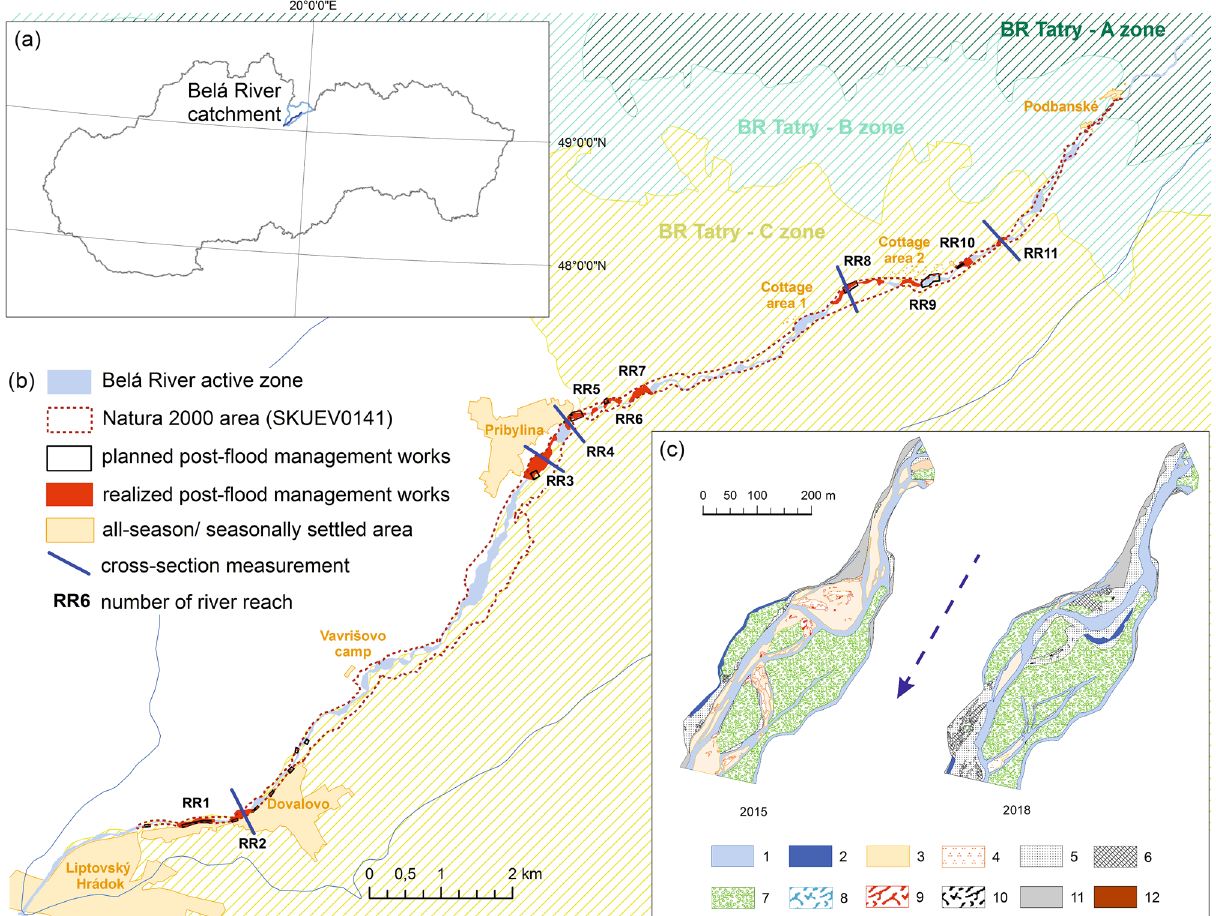
Figure 1. ( a ) Study area location in the north of Slovakia. ( b ) Spatial distribution of modified river reaches (sediment material transfer and extraction, transfer of heavy equipment) and repeated cross-section measurements in the Natura 2000 area of the Belá River (SKUEV0141). ( c ) Vectorized morphological channel parameters for the example of RR3 pre- (2015) and post-flood management intervention (2018), where 1—low flow channel area; 2—backwater; 3—bare mid-channel bar area (without vegetation); 4—mid-channel bar area with herb and shrub vegetation cover; 5—bare lateral bar area (without vegetation); 6—lateral bar area with herb vegetation cover; 7—island area with tree vegetation cover; 8—large woody debris (LWD) area in low flow channel; 9—LWD area on the mid-channel bar; 10—LWD area on the lateral bar; 11—floodplain area; 12—artificial structure area. Dashed arrow represents flow direction. This figure was generated in ArcMap 10.3